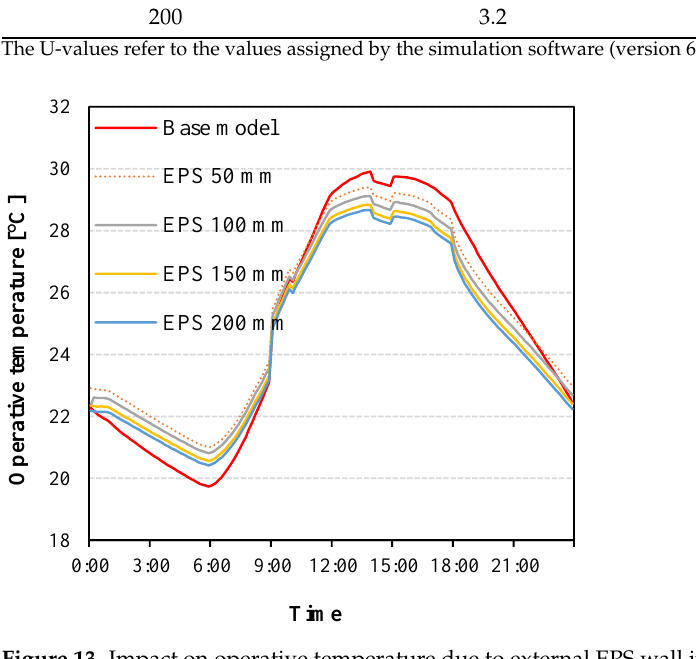
Figure 13. Impact on operative temperature due to external EPS wall insulation.